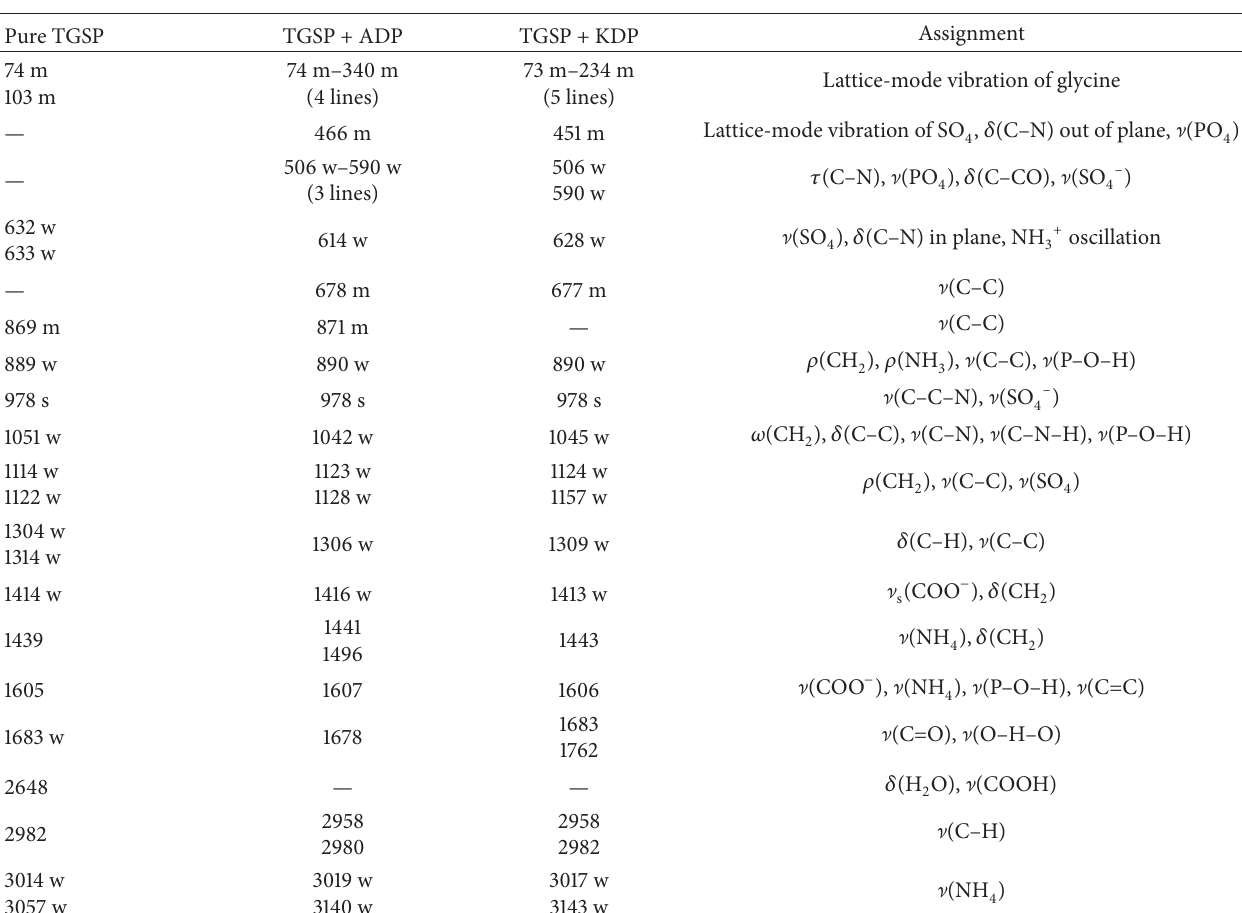
Table 3: FT-RAMAN analysis.